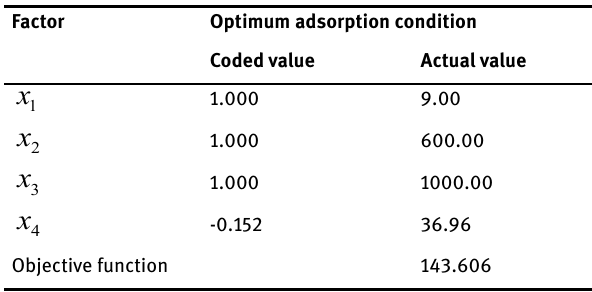
Table 5: Optimum adsorption solution of the optimization model in Equation (6).